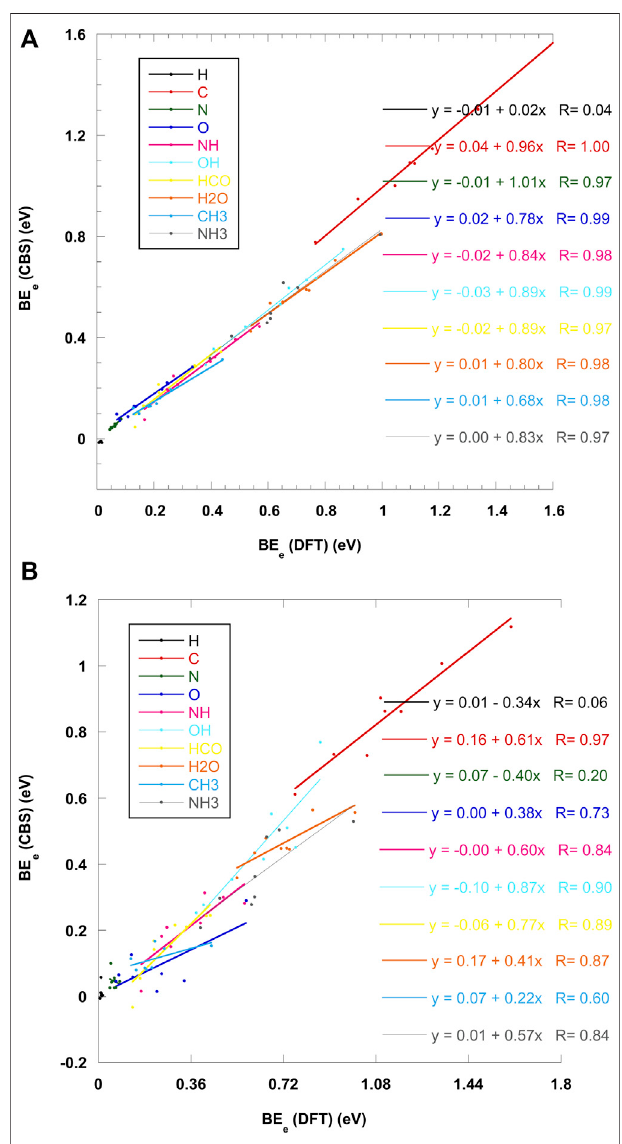
FIGURE 9 | Effect of scaled ZPE on ONIOM( ω B97X-D/6-31+G**:PM6) BE ’ sforamorphousices (A) EffectofCBSsinglepointonZPE-correctedBE ’ s for amorphous ices (B)